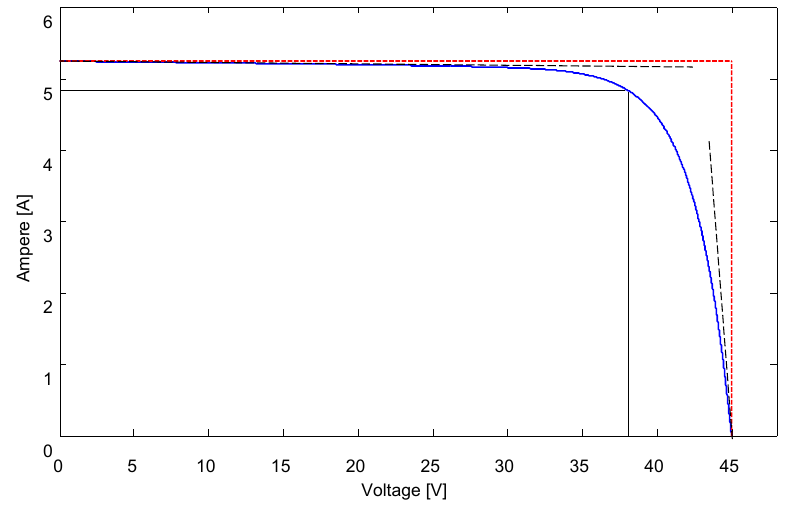
Figure 2. Current ‐ voltage (I ‐ V) curve for a typical photo ‐ voltaic (PV) module. Figure 2. Current-voltage (I-V) curve for a typical photo-voltaic (PV)